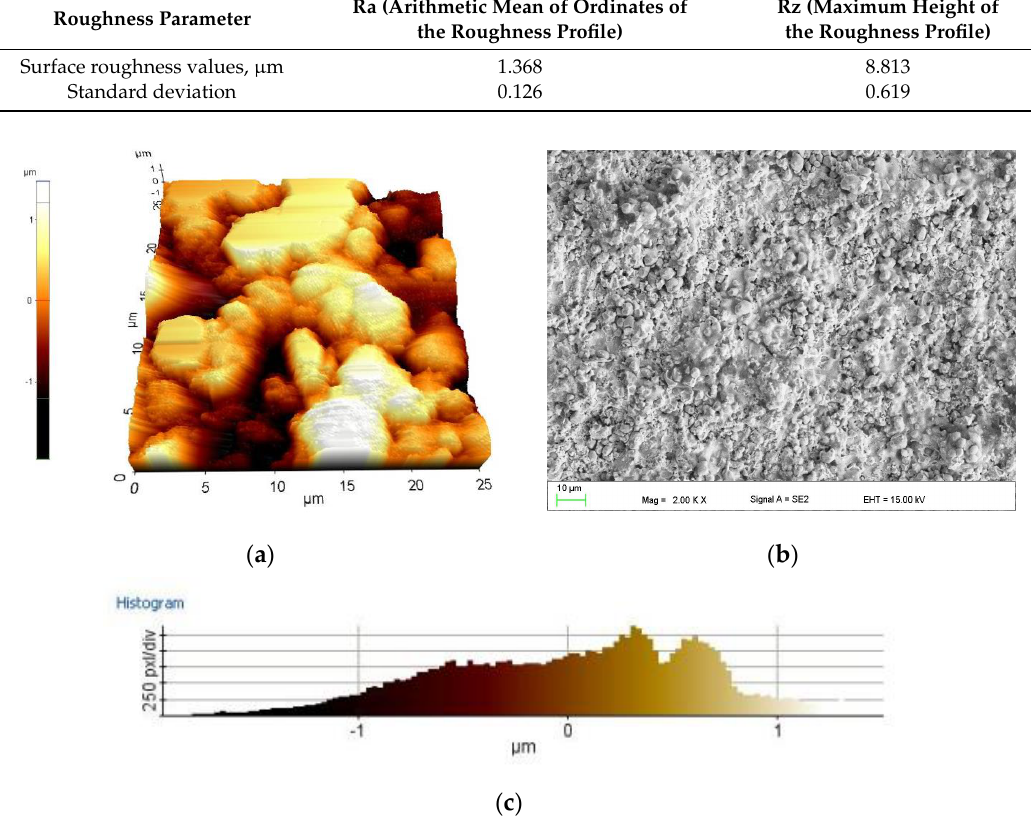
Figure 6. Topography of the thermally sprayed coating surface AFM ( a ) and SEM ( b ); roughness histogram over the entire surface of the coating ( c ).